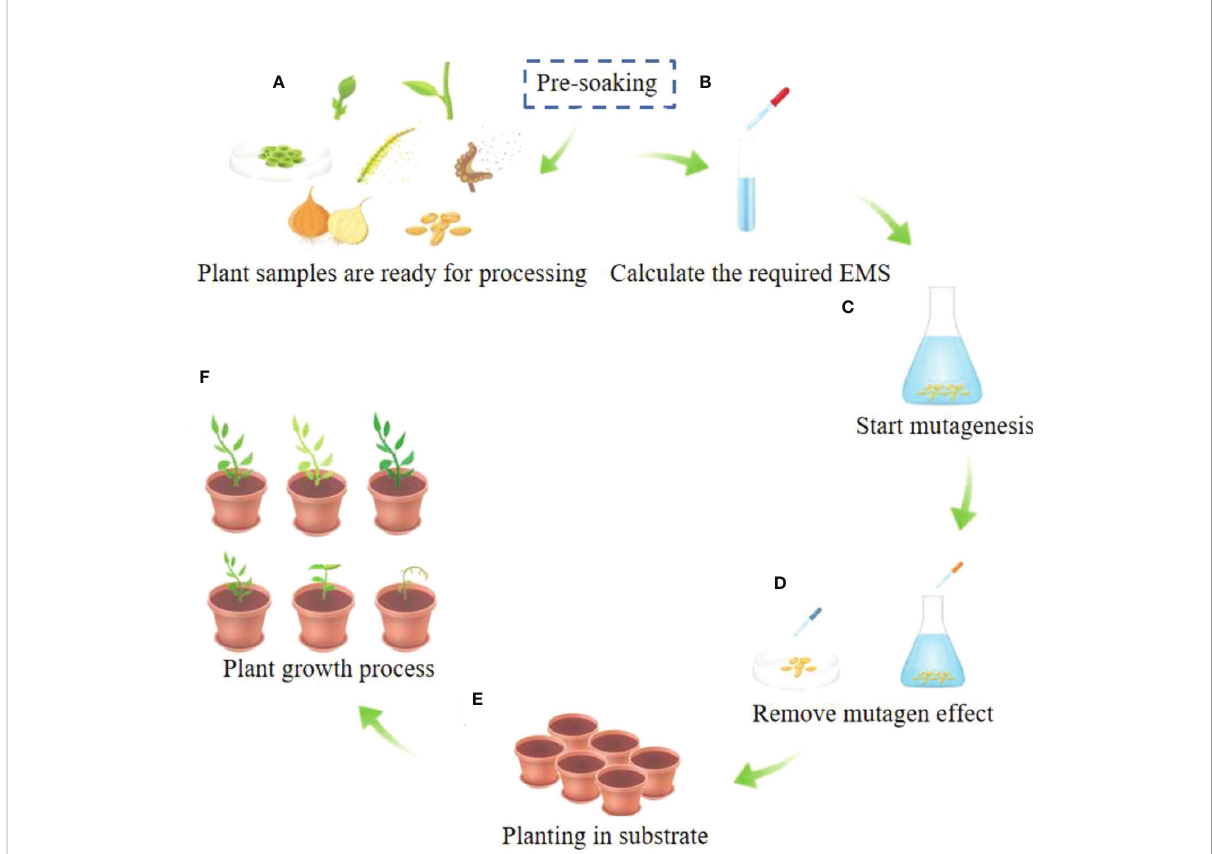
FIGURE 1 General steps of EMS mutagenesis. (A) Different prats of plants can be used for mutagenesis. The parts of the plant shown in A are buds, branches, callus, pollen, spores, bulbs, seeds and other parts of the plant tissue. (B) Determine the required EMS mutagenesis concentration and mutagenesis duration to profrom mutagenesis, and perform the mutagenesis. The preferred mutagenesis concentration range is 0.01%-4% and the duration range is 0.5h-12h. (C) Start mutagenesis with plant seeds as an example. (D) Rinse after mutagenesis or add mutagenesis terminator. (E) Planting in culture substrate. (F) After the seedlings grow, various phenotype can appear and carry out identi fi cation and further